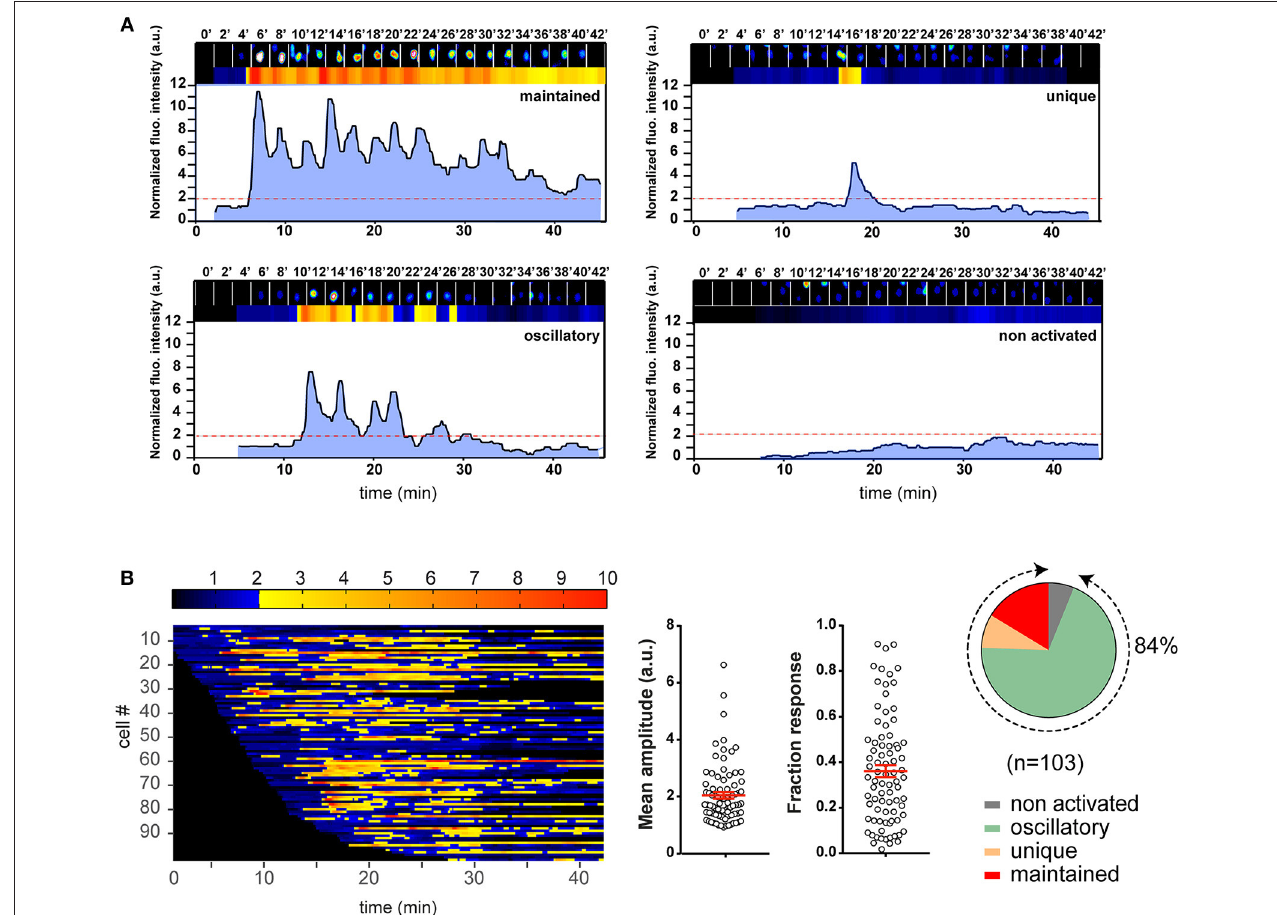
FIGURE 2 | Illustration of the T cell calcium response analysis with an example experiment. Naive 3A9 TCRtg CD4 + T cells were loaded with Fluo-4 PBX before incubation at 37 ◦ C for 45min with COS-A k pulsed with 10 µ M HEL 48–63. Time-lapse movies of T cells were made using confocal microscope as described in Materials and Methods. (A) Single cell fluorescence recordings analyzed by MAAACS and categorized into different classes according to the magnitude and shape of fluorescence signals. The examples of four different response types are shown. In each panel, the top row is made up of 2 min-delayed snapshots of raw images of a cell. Just below are the normalized fluorescence intensities displayed in the form of a bar code and a line profile, respectively. The non-activated cells are defined as cells whose normalized fluorescence intensities have never reached the activation threshold (set at 2.0, red dotted line, see Methods and Materials for more details) along the whole trace. For the activated cells, we defined a response as “maintained” when the response fraction (RF) was higher than 0.8, and “unique” when the response fraction was lower than 0.2 with a single burst. In all other situations, calcium responses were “oscillatory.” (B) Color barcoding and calculation of the analytical parameters of the calcium response. The normalized fluorescence amplitude of each cell is plotted along a horizontal line as a function of time with a color-coded intensity (dark to blue below the threshold of activation and yellow to red above the threshold of activation). The analytical parameters of the calcium response, i.e., the mean amplitude (MA) and RF calculated by MAAACS are plotted (mean ± SEM). The global overview of the cell response heterogeneity is summarized in the form of a pie